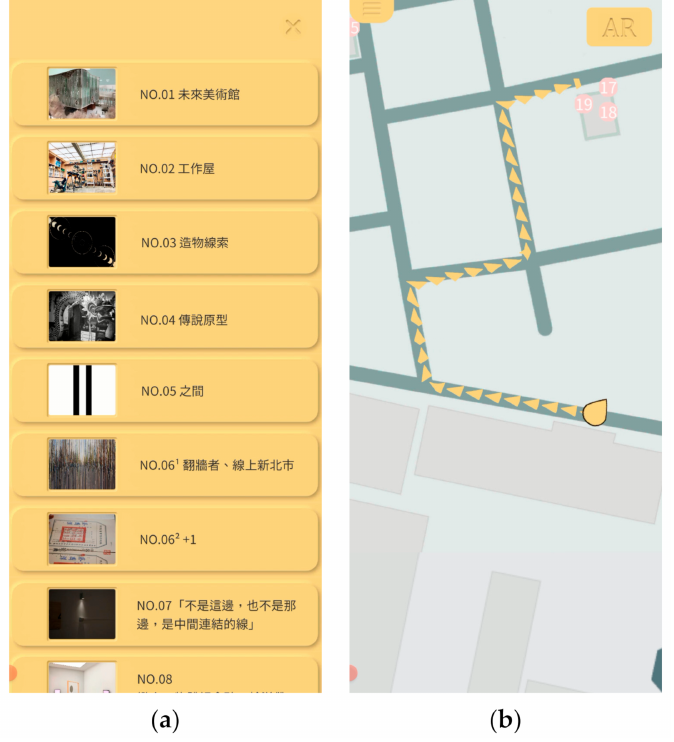
Figure 4. ( a ) List of artworks; ( b ) shortest-route